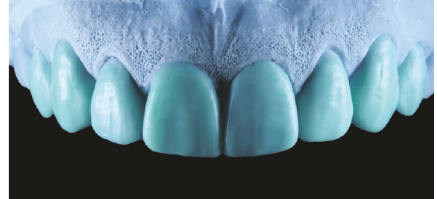
Figure 7: Vestibular reduction until the painted grooves are removed; this ensures a controlled reduction for the ceramic